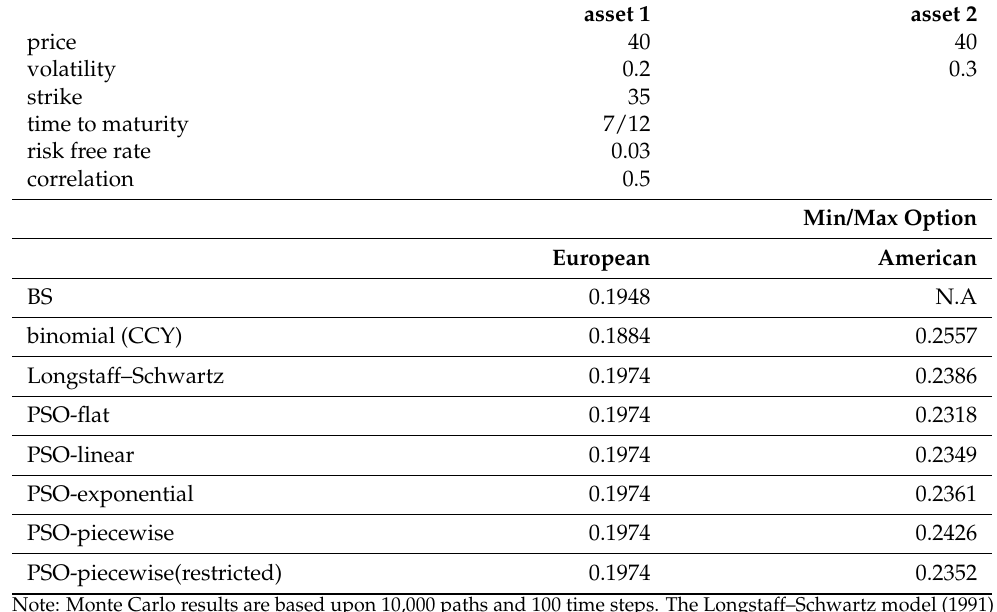
Table 2. Put option on Min/Max. The option payoff is max { K − max { S 1 , S 2 } ,0 }